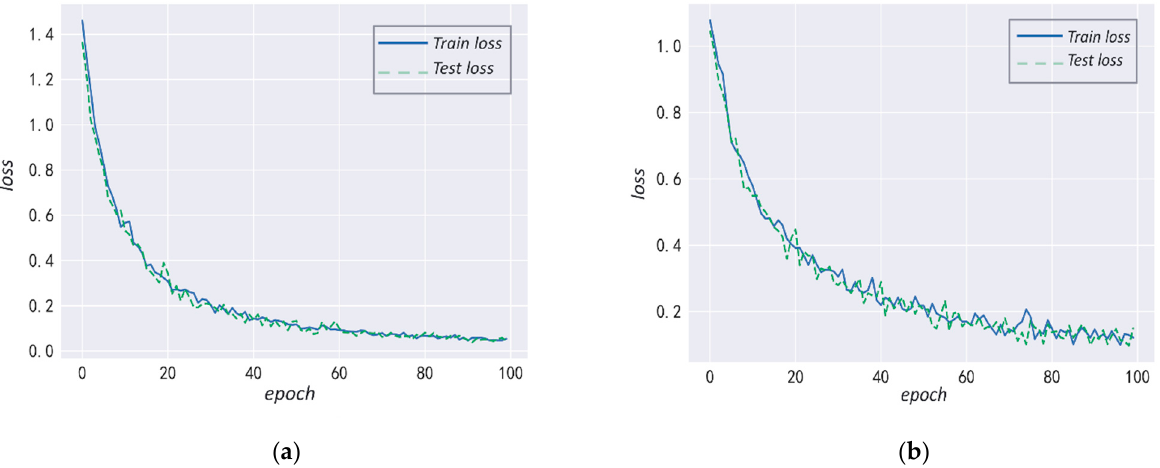
Figure 3. The loss curve of the state–action classification network, picture ( a ) is the loss curve of the highway environment; ( b ) is the loss curve of the intersection environment.